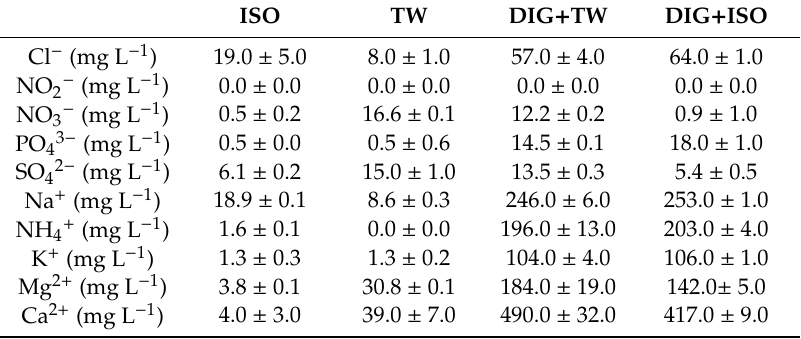
Table 2. Characterization of initial cation and anion concentration in synthetic medium (ISO), tap water (TW), digestate diluted 1:5 with ISO and tap water (DIG + ISO and DIG + TW) before microalgae inoculum ( n = 2). ISO TW DIG + TW DIG +